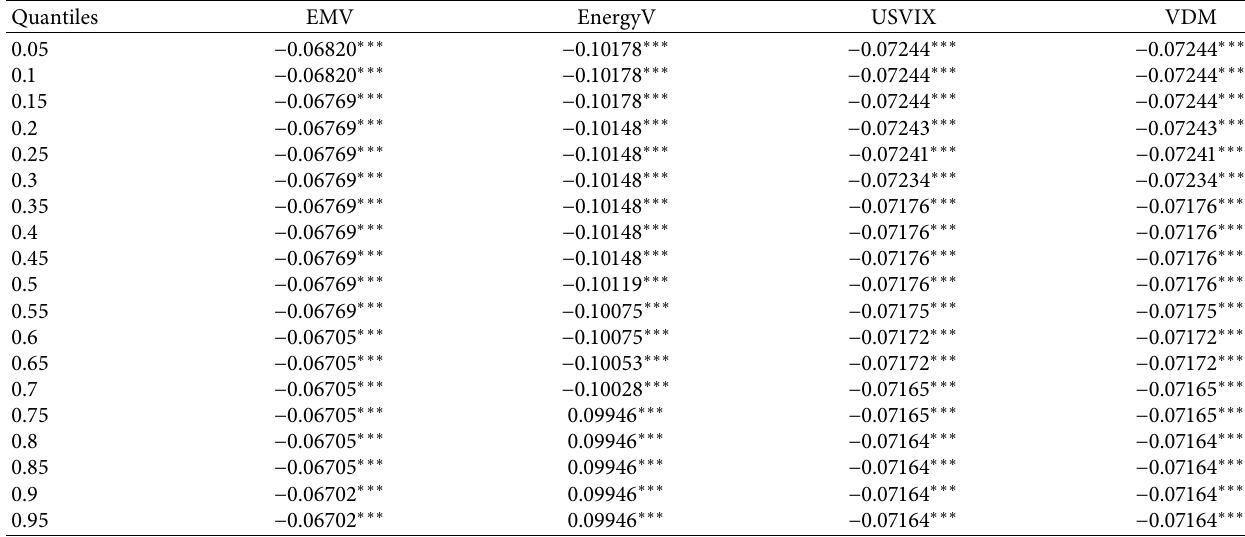
Table 9: Effect of volatilities on